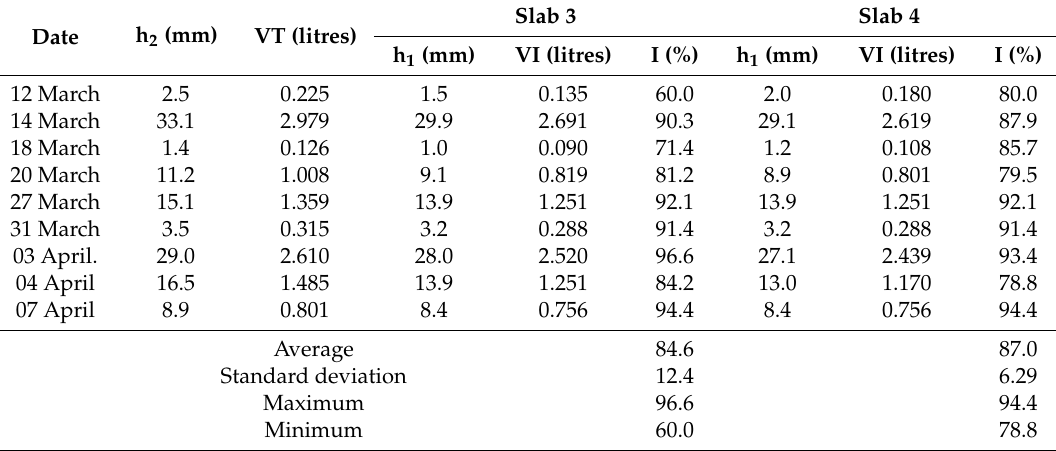
Table 3. Total volume of rain (VT), infiltration volume (VI) and rainwater infiltration (I) for draining asphalt concrete slab 3 (styrene-butadiene-styrene (SBS) polymer without water cycling) and slab 4 (SBS polymer with water